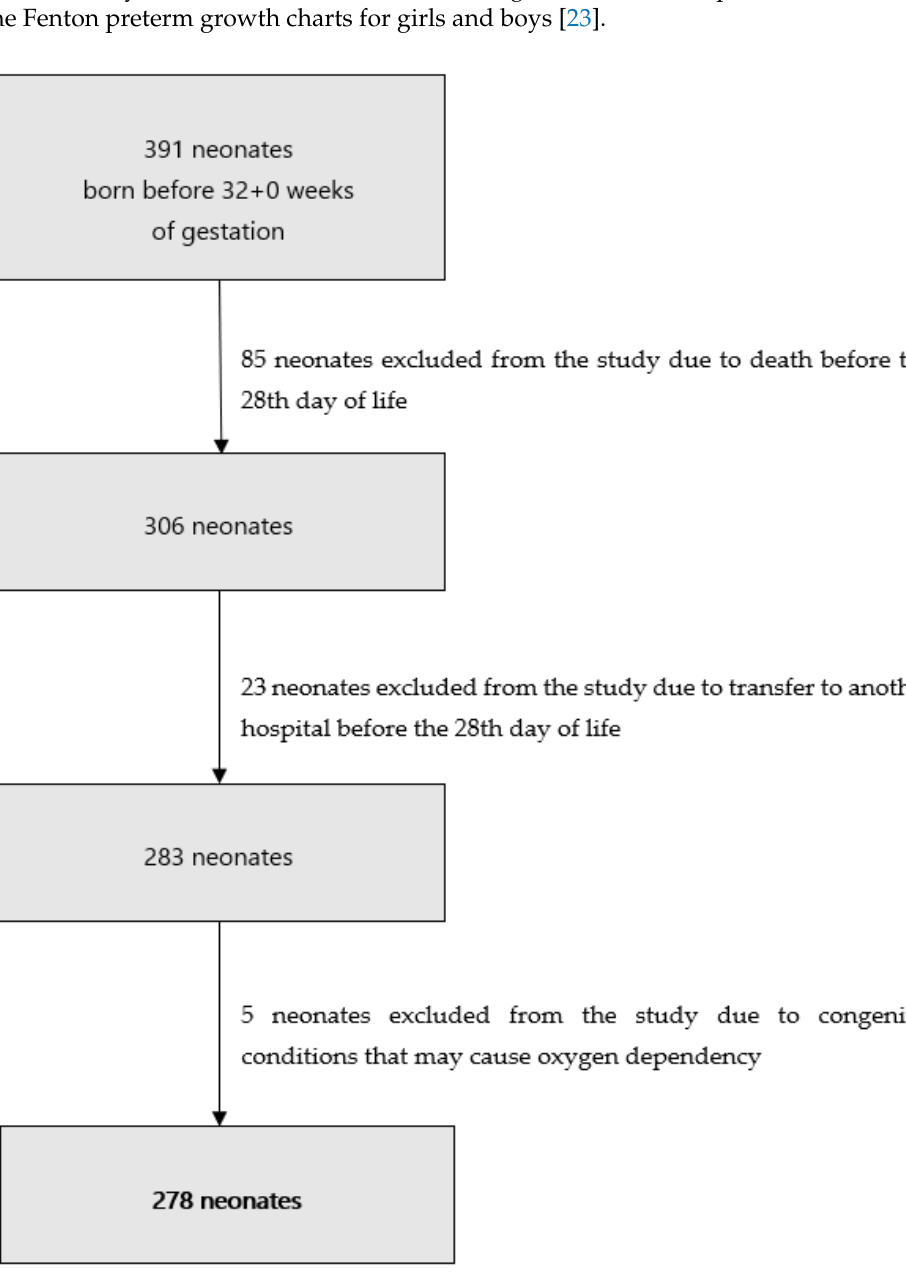
Figure 1. Process of qualification to the study.